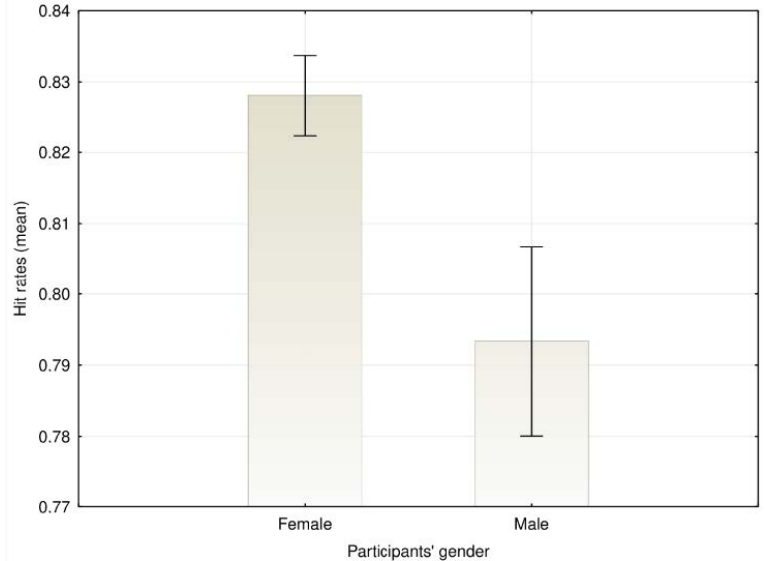
Figure 1. Mean agreement rates for the emotion recognition depending on the participants’ gender (error bars represent 95% confidence intervals [CIs]).